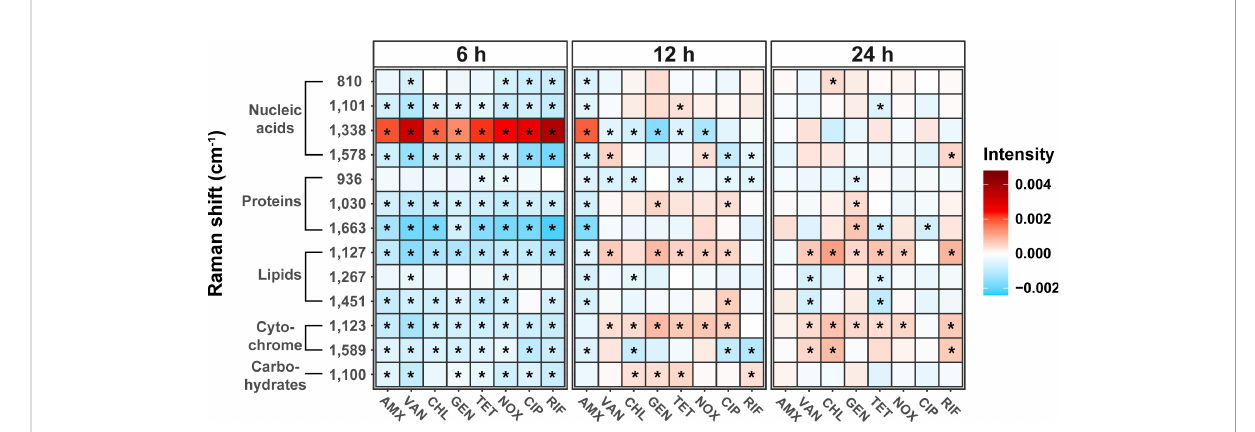
FIGURE 4 Changes in bacterial biochemical composition with different mechanisms of antibiotics and treatment time using Raman spectrum. Heat maps were generated to show the peak intensity trends over time in antibiotic treatment. Each antibiotic-treated sample ’ s mean spectral intensity was colored by subtracting the average spectral intensity of each time control group. The difference from control was considered signi fi cant in P- value (*P < 0.01, t